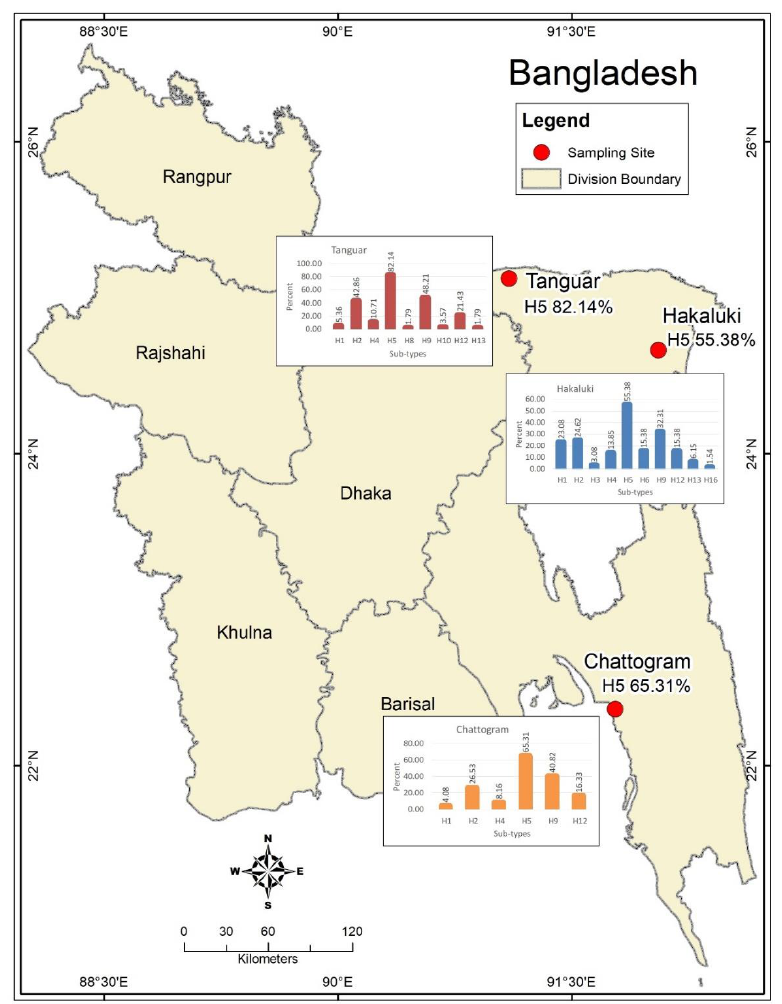
Figure1. AmapofBangladeshshowingthestudyareasandthespatialdistributionofAIVsero-subtypes. Figure 1. A map of Bangladesh showing the study areas and the spatial distribution of AIV sero- subtypes. The map was plotted using ArcMap, version 10.2, Environmental Systems Research The map was plotted using ArcMap, version 10.2, Environmental Systems Research Institute, Redlands, Institute, Redlands, CA, USA. CA,